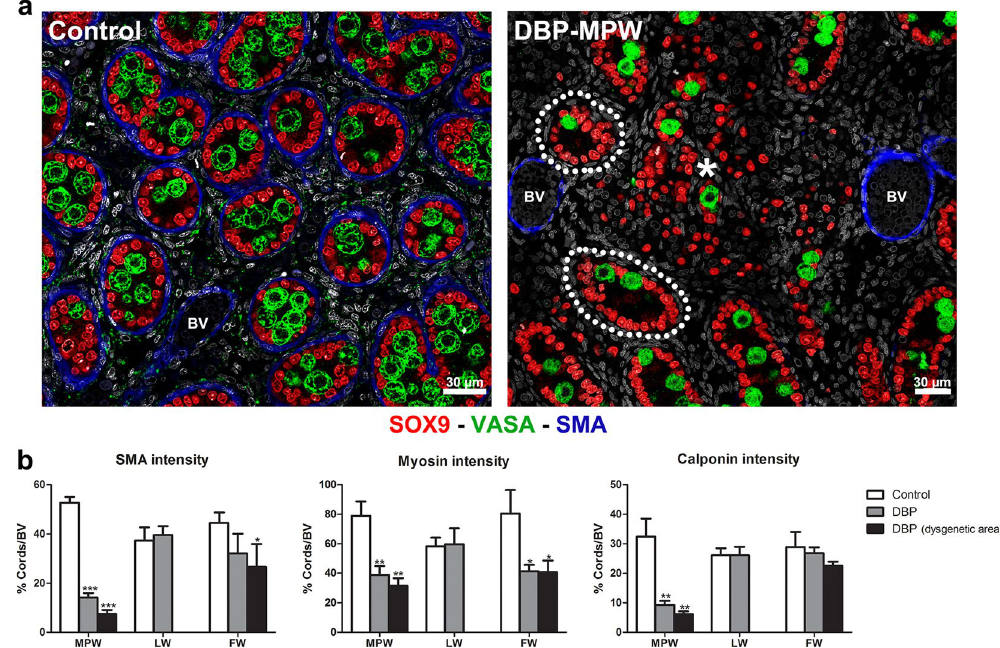
Figure 6. Evidence for functional impairement of peritubular myoid cells around the seminiferous cords in relation to dysgenetic areas in testes of DBP-exposed fetuses. ( a ) sections triple immunostained for SOX9 (red, Sertoli cells), VASA (green, germ cells), and smooth muscle actin (SMA, blue, peritubular myoid cells and some blood vessels, BV). While the control section shows normal SMA immunostaining in peritubular myoid cell around the seminiferous cords and in smooth muscle cells of blood vessels (BV), in the DBP-MPW exposed fetuses the seminiferous cords close to a dysgenetic area ( * ) lack SMA immunostaining (examples circled by a white dotted line), although SMA is still expressed normally in adjacent BV. ( b ) Quantitative analysis of the immunoexpression intensity for three different peritubular myoid cell functional markers (SMA, myosin, calponin) in the seminiferous cords, normalized to BV immunoexpression of the same protein. Note that in the DBP-MPW and DBP-FW groups, immunoexpression of each marker in peritubular myoid cells was reduced in relation to BV immunoexpression intensity (except for calponin in DBP-FW), while the DBP-LW group showed immunoexpression intensity comparable to controls. Values are means ± SEM for 5–6 animals per group. Data were analysed by one-way ANOVA followed by Tukey’s post hoc test. * p < 0.05, ** p < 0.01, *** p <